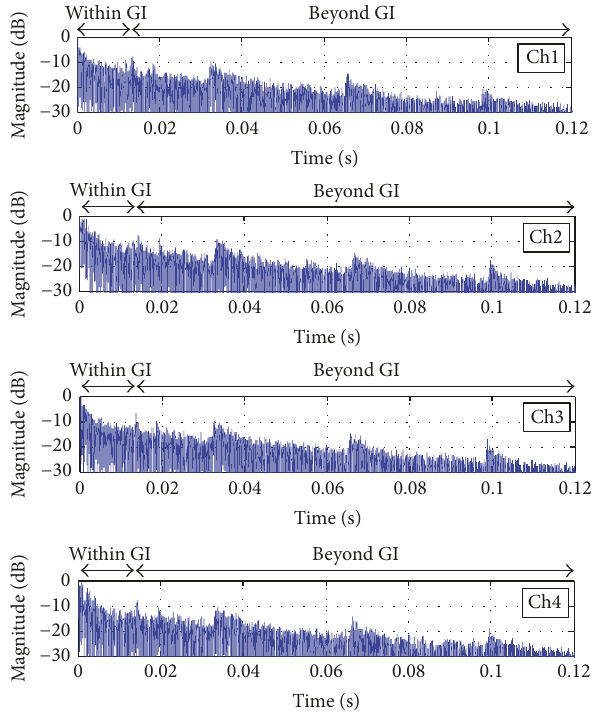
Figure 14: Delay profile for 8m distance.